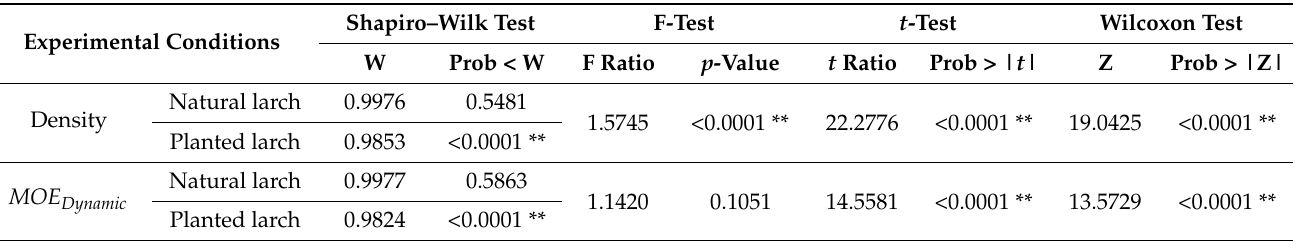
Table 3. t -Test and Wilcoxon test results of the density and MOE.